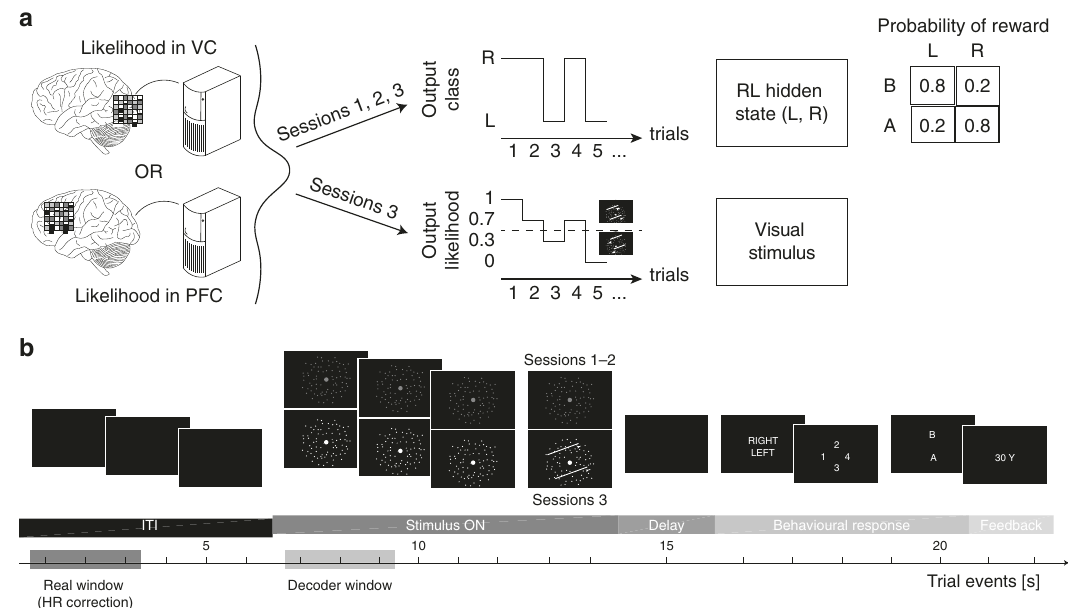
Fig. 1 Design of the hidden-brain-state reinforcement learning task. Subjects ( N = 18) were assigned to one of two groups, which differed in the brain region targeted by their decoder: visual cortex (VC, N = 9) or prefrontal cortex (PFC, N = 9). For all analyses, the brain region was treated as a between- subjects factor; unless this factor displayed a signi fi cant effect, subjects were pooled into one cohort. a The learning task consisted of three consecutive sessions. In each session, decoding was performed with fMRI multivoxel patterns; the decoder output was used in real time to determine the RL state on a trial-by-trial basis. In a given RL state, only one action was optimal, with a high probability (0.8) of reward, while the other action had low reward probability (0.2). In the last (control), third session the output likelihood was also used to proportionally de fi ne the motion direction of the visual stimulus. Even in the last session, early trials had very low coherence, and only the latter half of the session had trials with coherence high enough to be easily detected and for subjects to consciously learn the rule. b Each trial started with a blank intertrial interval (ITI, 6 s). Random dot motion was then shown for 8 s (Stimulus ON). On the fi rst two sessions, the motion was entirely random and the dots were dim (20% of maximum), while on the third session the last 2 s had increasingly higher coherence (partially determined by the decoder ’ s likelihood). Subjects then had to report the direction of motion (the latent state), their con fi dence in their choice, followed by a gamble on one of two actions (A or B). After action selection, the outcome for the current trial (reward: 30¥/0.25$, or no reward: 0¥/$) was shown on the screen. Accounting for the haemodynamic delay meant that decoding was performed on data corresponding to the ITI. This ensured that mental imagery or illusory perception could not index the latent state determined by the decoder from neural activity. HR haemodynamic response delay, L left, R right.